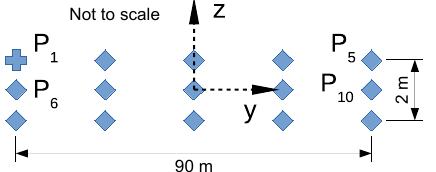
Figure 4. Schematic of grid points of wind speed data (minimal test case). We arbitrarily chose the right-hand top point ( P 1 ) to be the base